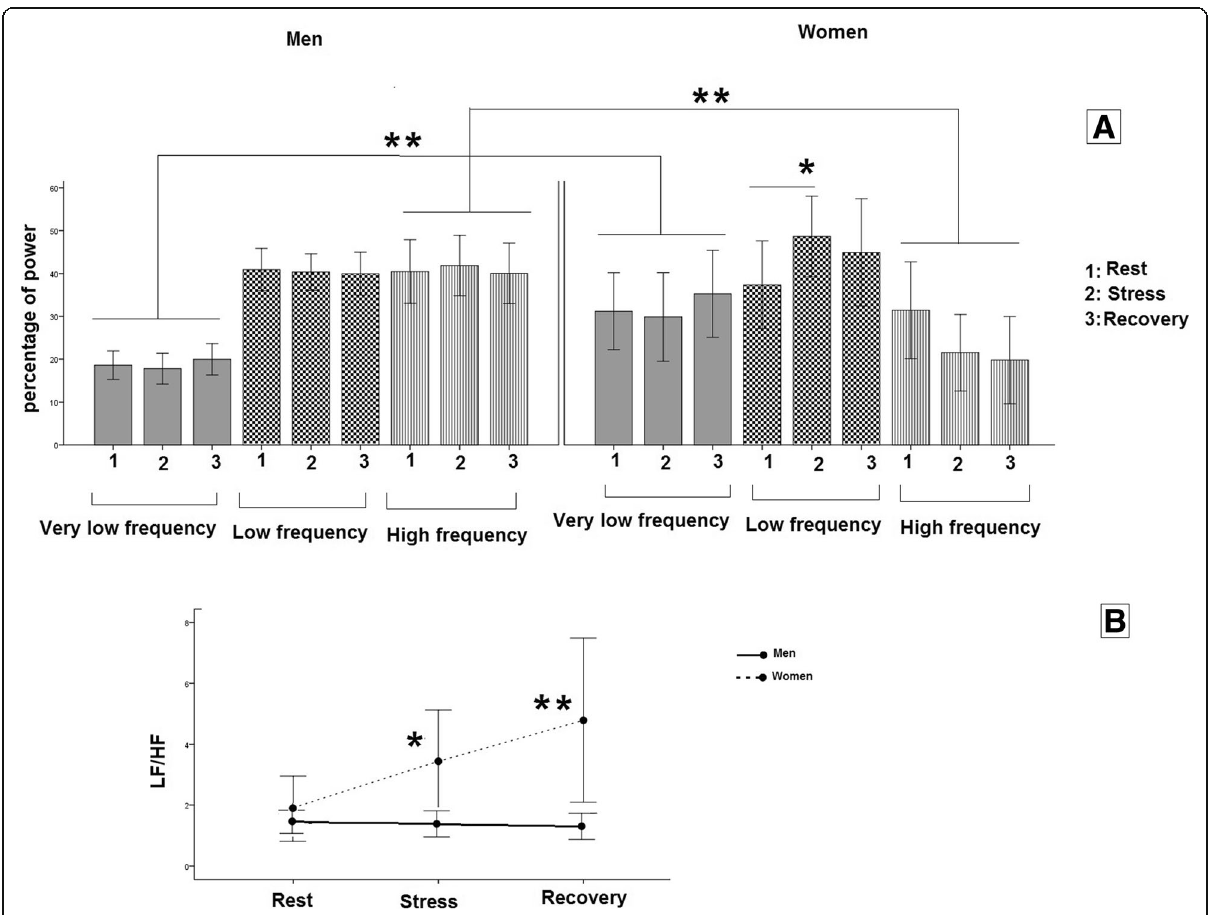
Fig. 5 The mean and CI 95% of the percentage of HRV ( a ) power frequency and ratio of LF/HF ( b ) in the men and women, in three phases of the